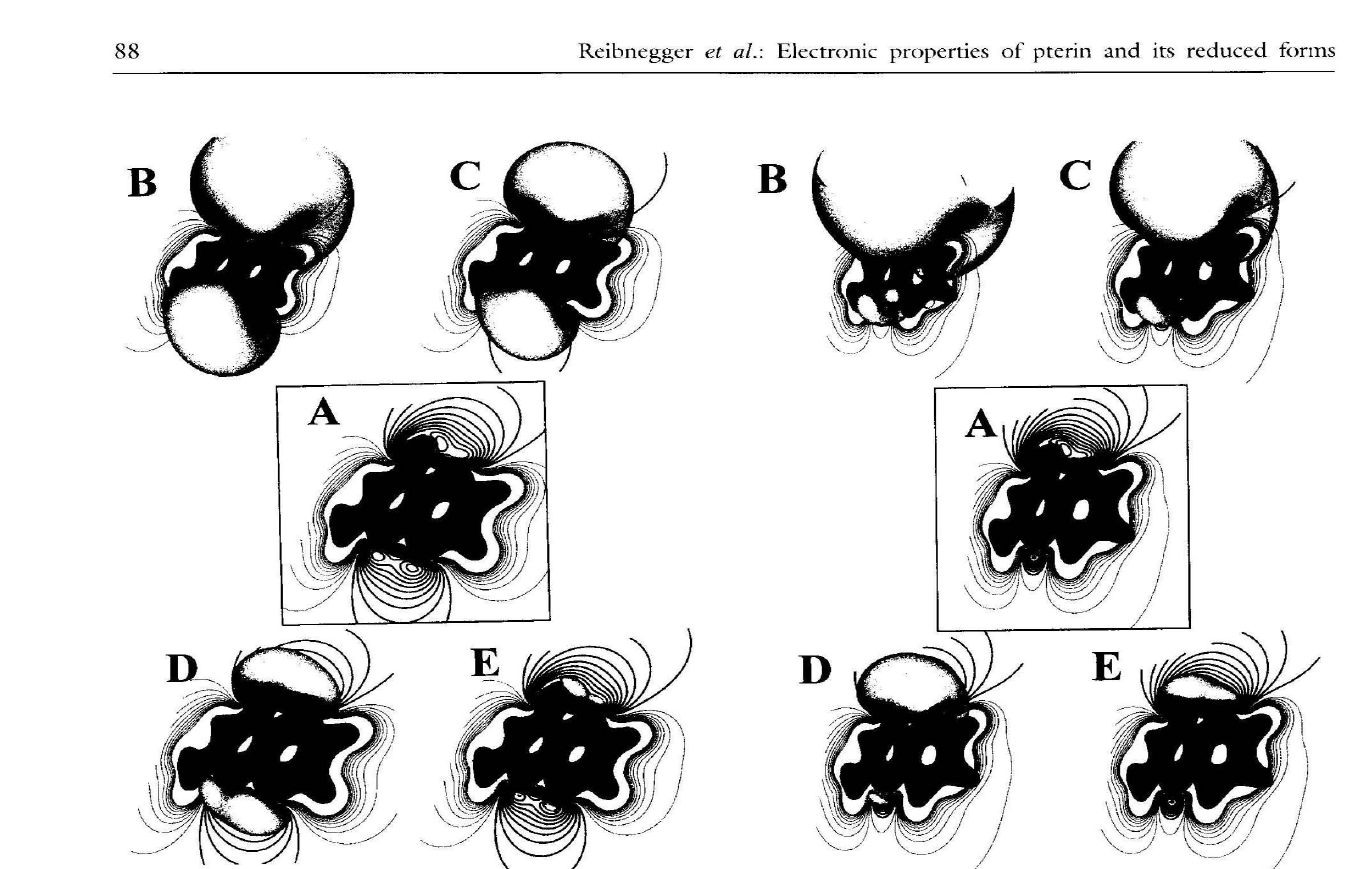
Figure 6. Electrostatic potential of 7,8-dihydropterin. The molecule is represented by the isodensity surface showing electronic charge density of 0.10 a.u. A) Elec trostatic potential in the molecular plane (thin lines, po sitive potential from 0 .01 (outermost thin isoline) to 0.10 a.u.; thick lines, negative potential from -0.01 (outermost thick isoline) to -0.15 a.u. (the global min imum value). B) to E ) Same as A), overlaid with iso surface representing the electrostatic potential -0.01 a.u. (B); -0.02 a.u. (C); -0.05 a.u. (D); and -0.10 a.u.